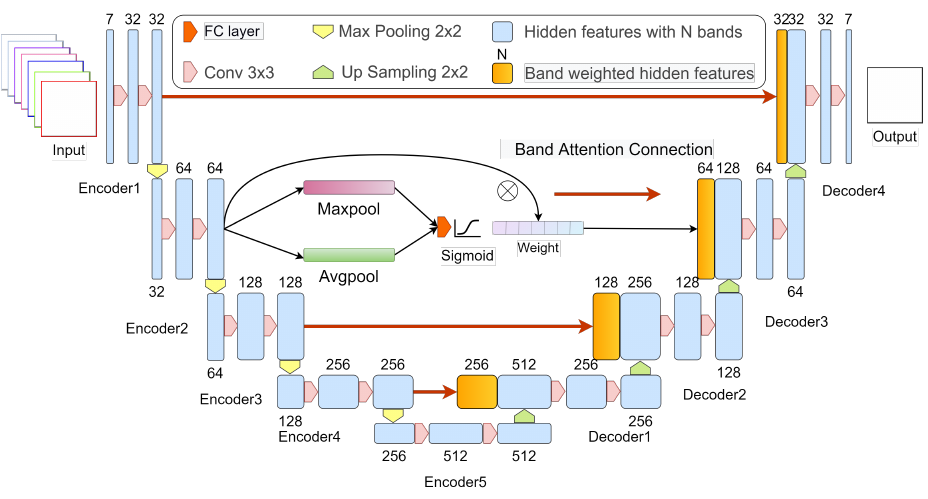
Figure 3. The structure of proposed